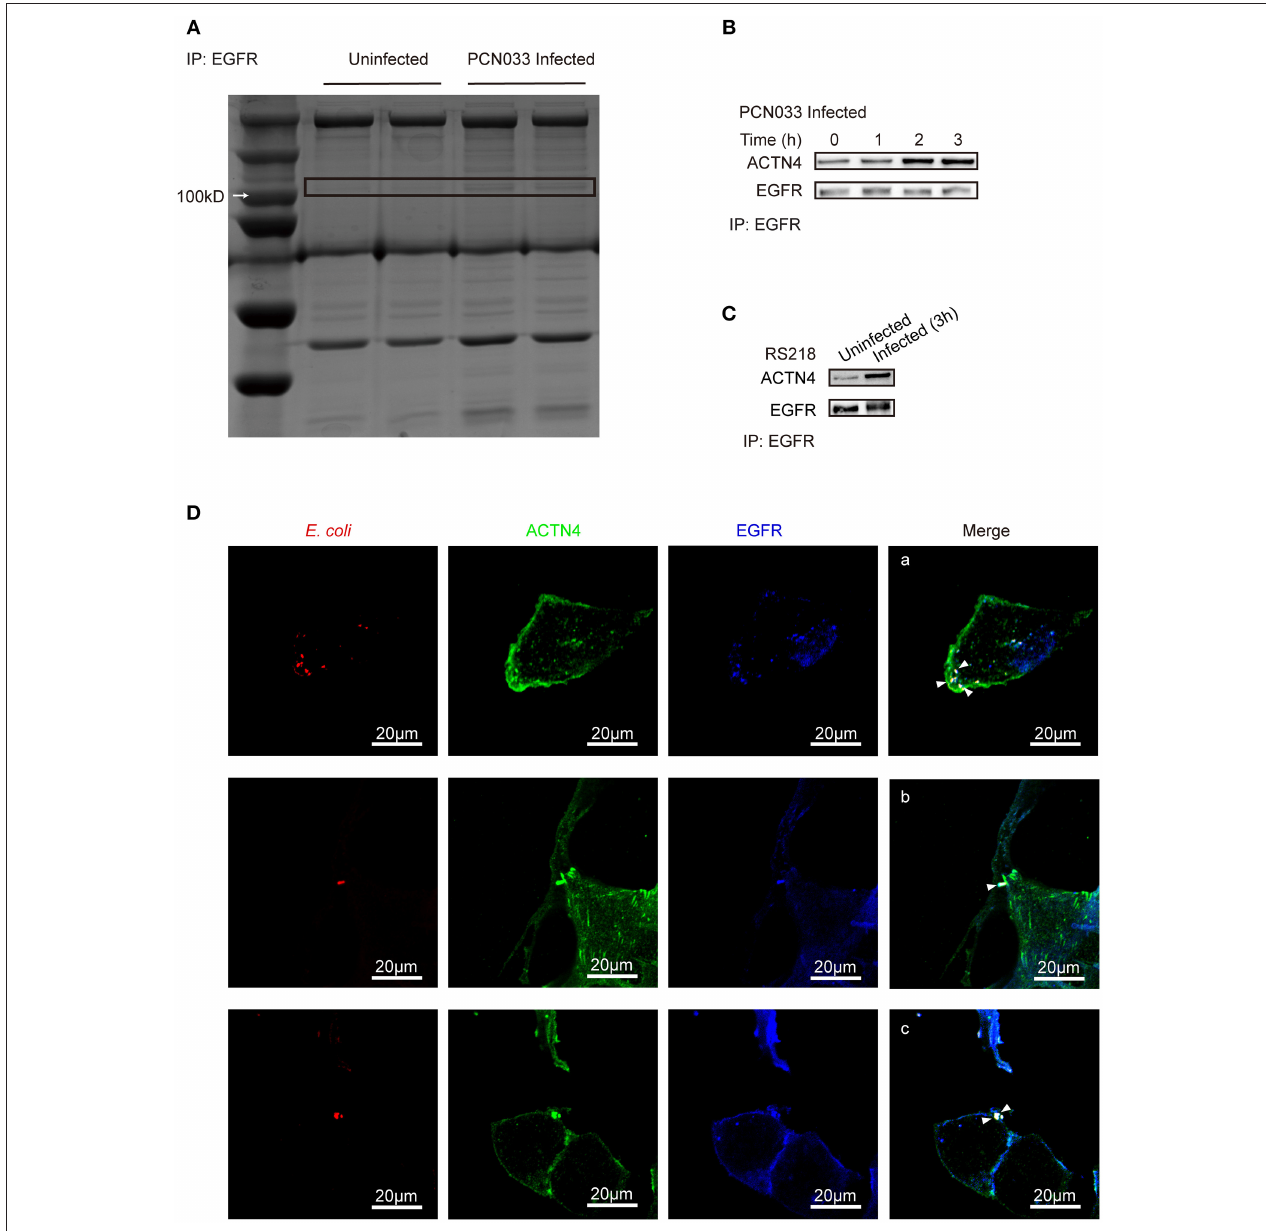
FIGURE 4 | Identification of ACTN4 as an EGFR interacting protein in hBMECs upon meningitic E. coli infection. (A) SDS-PAGE comparison of the immunoprecipitation products from uninfected and infected cells. Immunoprecipitation was conducted with an anti-EGFR antibody. (B,C) Immunoprecipitation and western blotting verification of the EGFR–ACTN4 interaction in response to infection with meningitic E. coli PCN033 (B) and RS218 (C) . (D) Confocal immunofluorescence microscopy showed the meningitic E. coli co-located with EGFR and ACTN4. E. coli was labeled with Cy3, ACTN4 was labeled with FITC, and EGFR was labeled with Dylight 405. Cells were mounted and visualized using the Zeiss LSM 880 confocal system. The scale indicates 20 µ m.